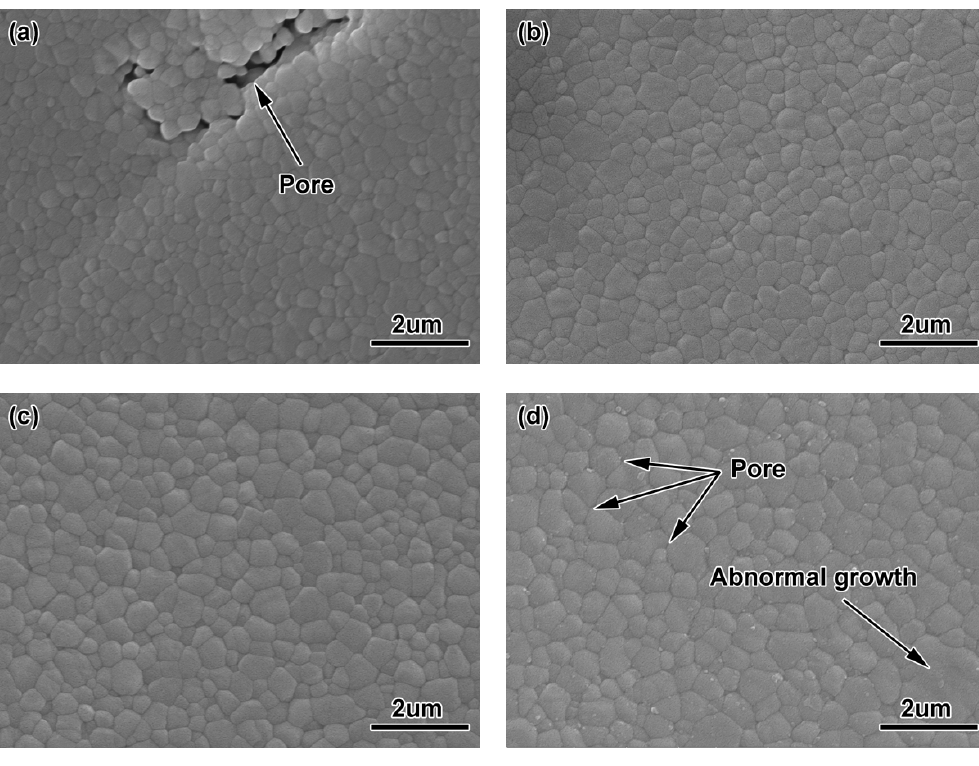
Figure 9. Microstructures of ZrO 2 samples using 200 nm powders sintered at different temperatures: